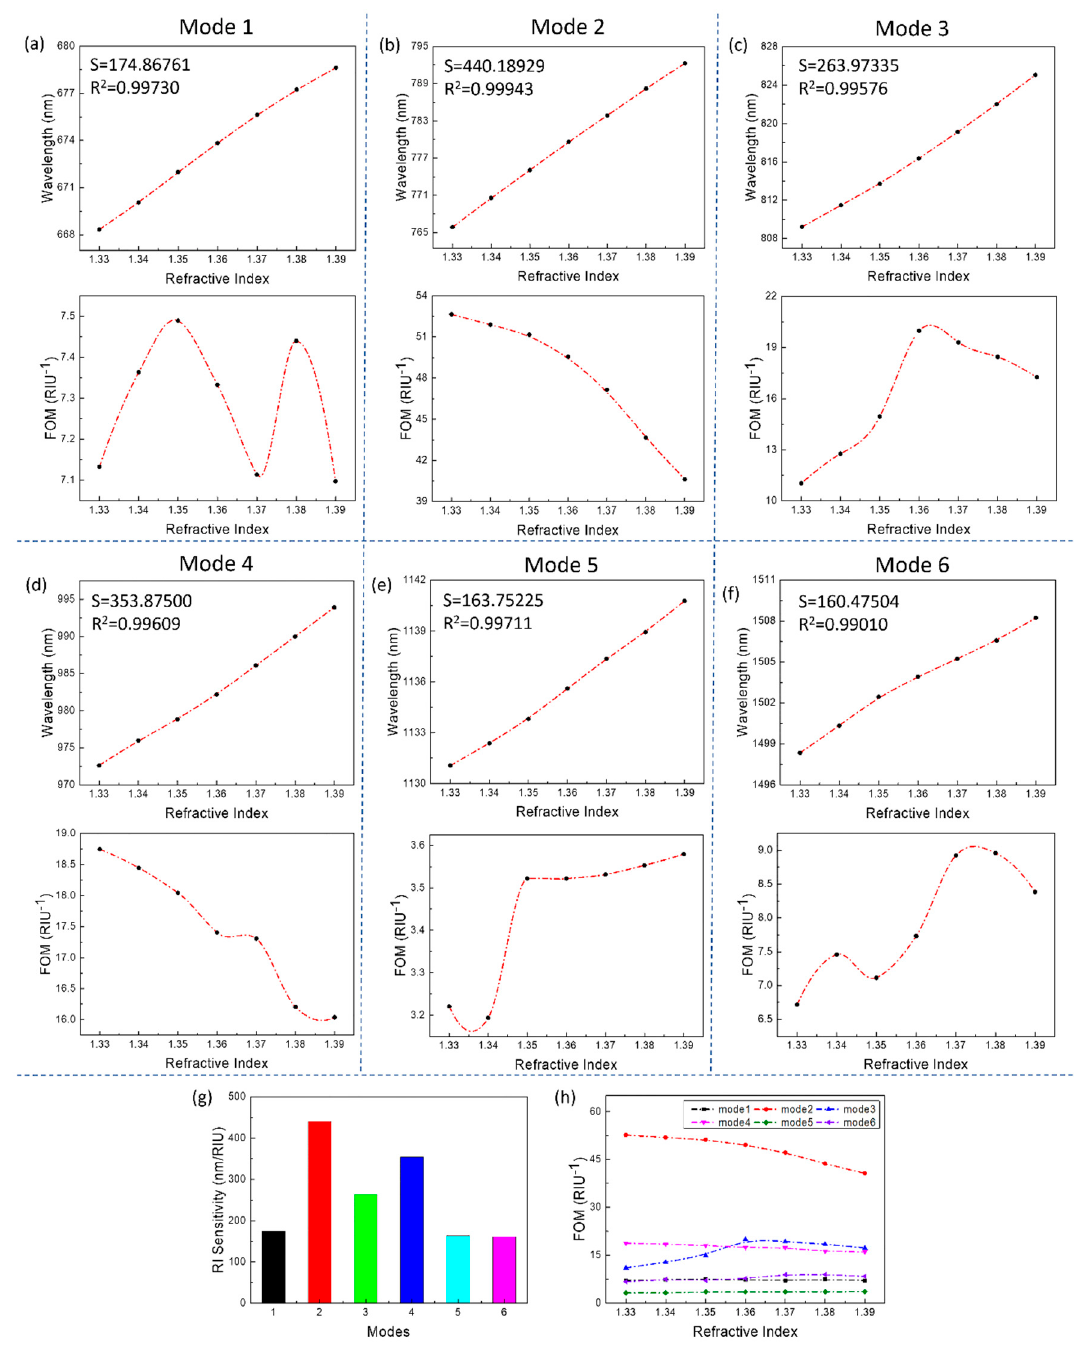
Figure 5. The sensing performance of the designed structure under standard parameters. ( a – f ) The graphs of the sensitivity and figure of merit (FOM) relative to the refractive index changes of all modes, respectively. ( g ) Histogram of the sensitivity of each mode. ( h ) Comparison of the FOM of each mode. (The S and R 2 in the upper left corner are calculated based on linear fitting. The dashed line connecting the data points is simply connected with a smooth curve for readers as a guide for an eye.).